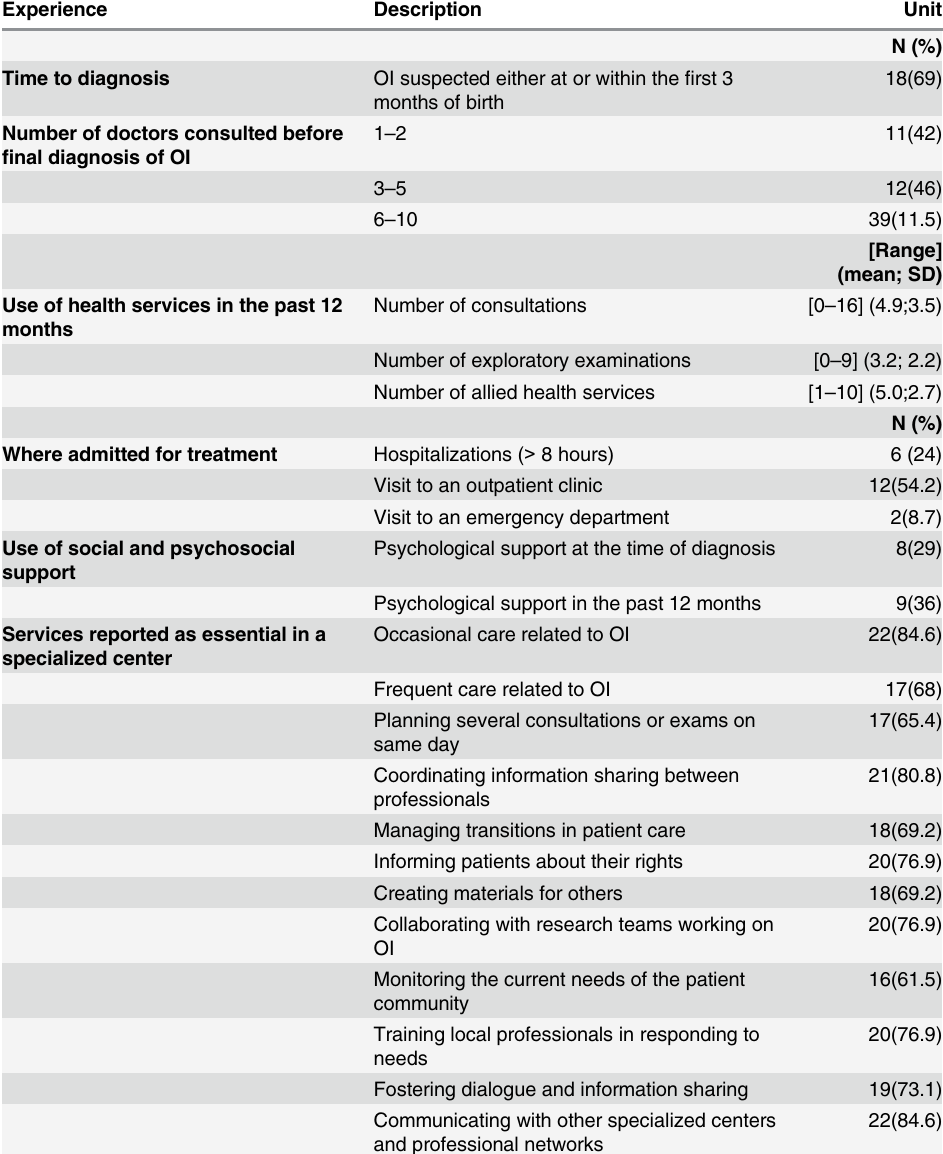
Table 2. Experiences while seeking care for